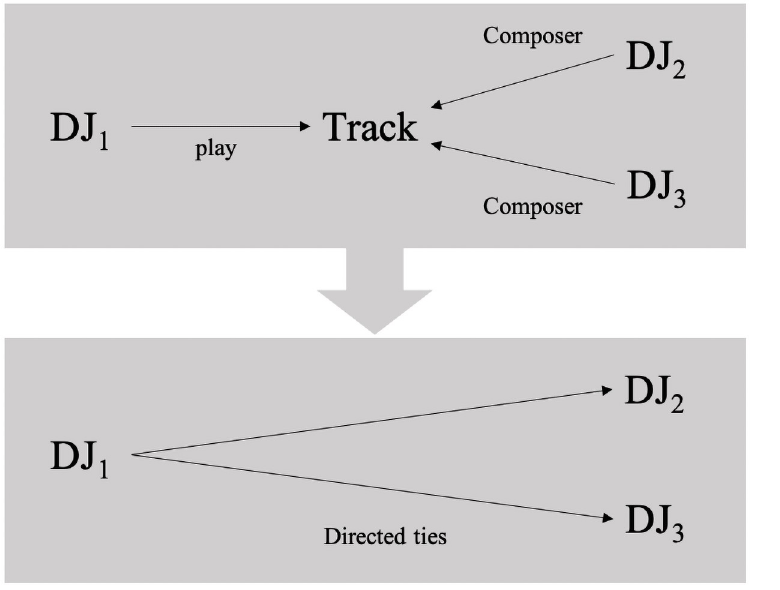
Fig 1. Construction of the DJ citation